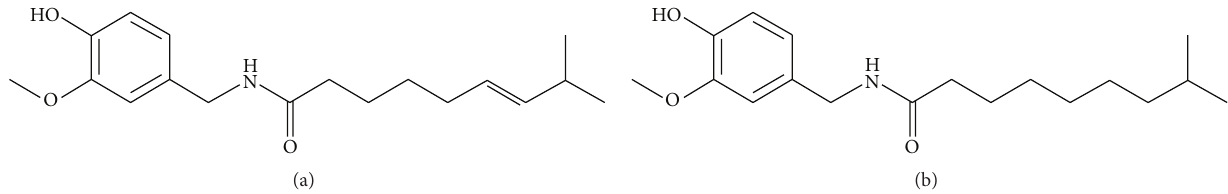
Figure 1: Chemical structure of (a) capsaicin and (b) dihydrocapsaicin (image 1b by Vyacheslav Nasretdinov via Wikimedia Commons).